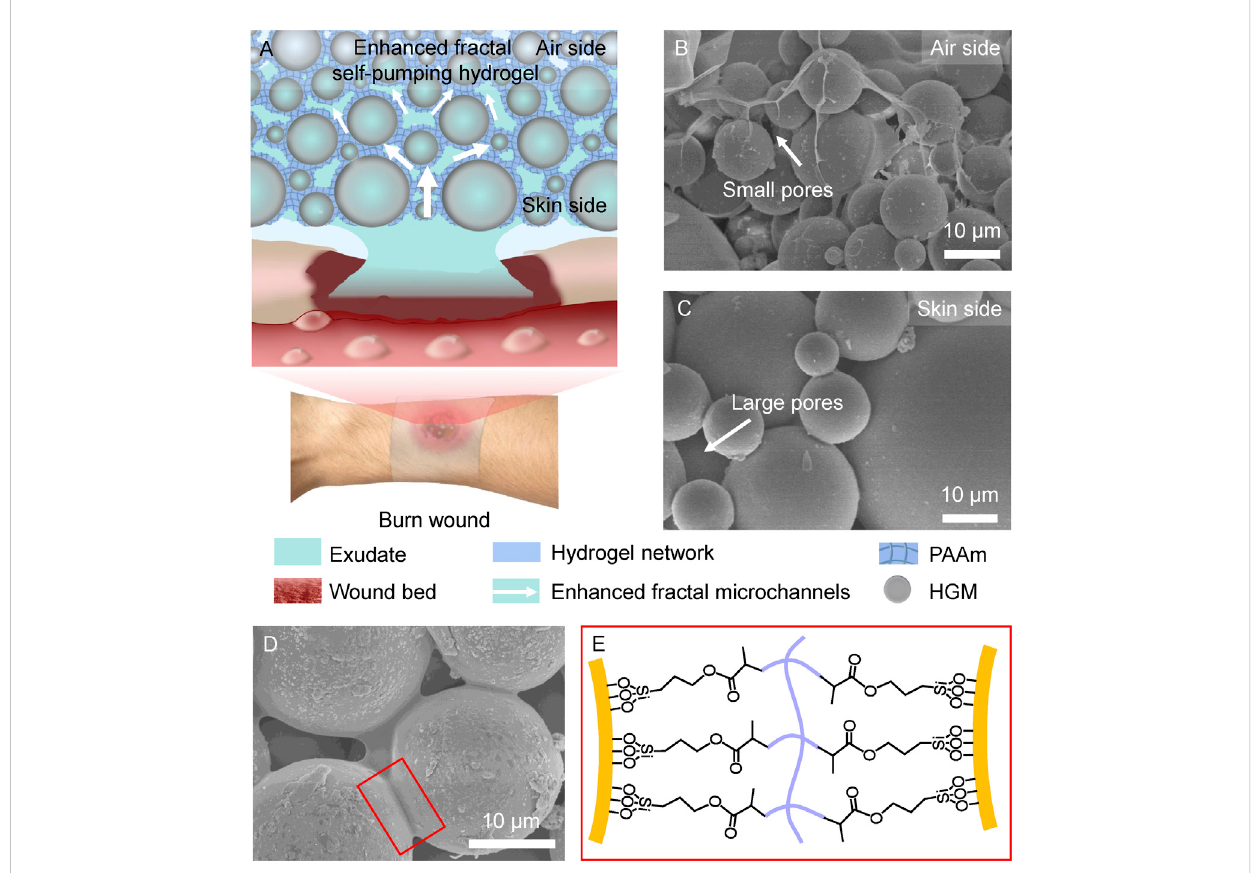
FIGURE 1 Design of the enhanced fractal self-pumping (EFS) hydrogel dressing. (A) Illustration of the EFS hydrogel with enhanced fractal microchannels for draining exudates from burn wounds. (B, C) SEM images of the gradient HGM with small pores at air side (B) and large pores at skin side (C) in the EFS hydrogel. (D) SEM image of the hydrogel network between the adjacent HGM. (E) Schematic graph of connection between HGM and hydrogel network by silane coupling